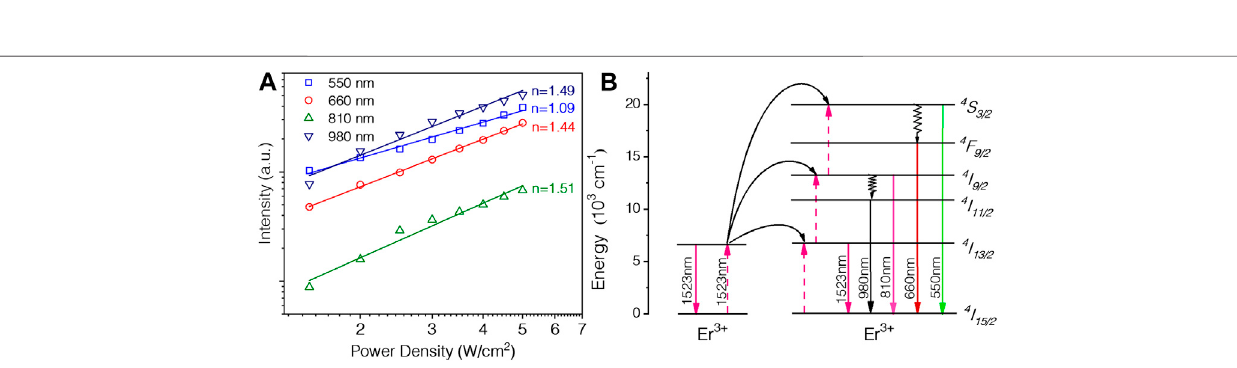
FIGURE 4 | (A) Dependence of four peaks versus pump power, and (B) the proposed energy transfer upconversion mechanism between Er 3+ ions.